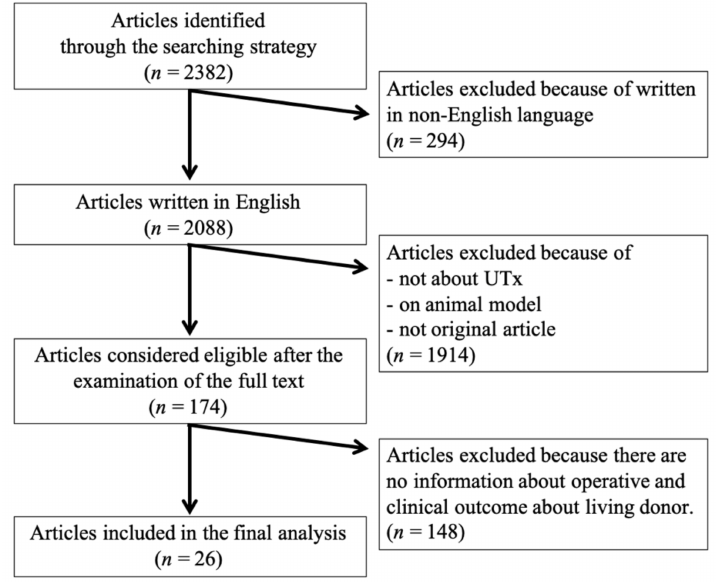
Figure 2. Flowchart of article